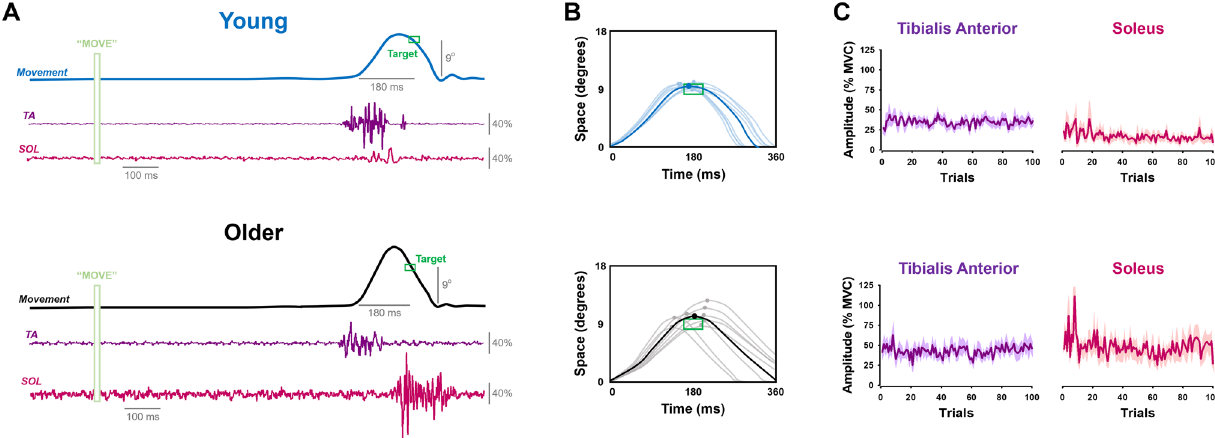
Figure 1. Movement endpoint control and muscle activation in young and older adults. Participants performed a goal-directed ankle dorsiflexion movement with the non-dominant foot that was restrained in an ankle device ( A ). Their goal was to exert an ankle dorsiflexion movement that reversed at the spatiotemporal target (9° movement in 180 ms). Older adults exhibited impaired endpoint control ( B ) and altered muscle activity for the Tibialis Anterior (TA) and Soleus (SOL) muscles ( C ). Specifically, older adults exhibited similar TA muscle activity but relatively more SOL muscle activity compared with young